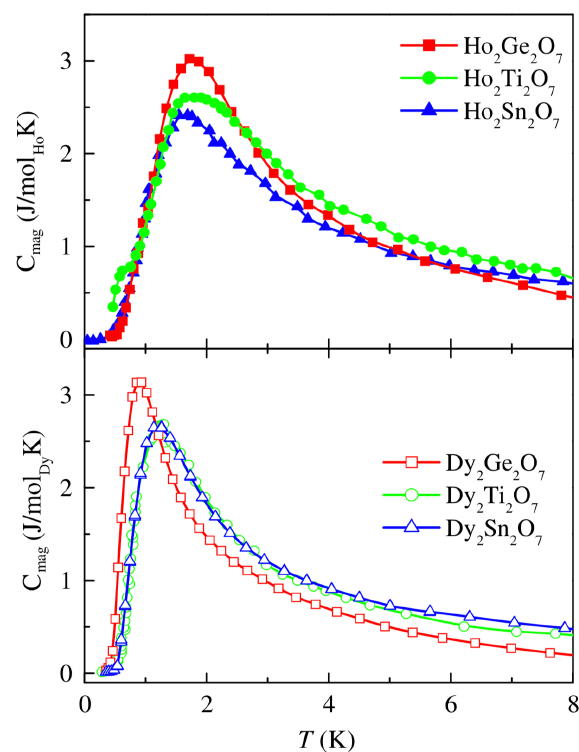
Figure 7. (color online) Magnetic specific heat for all six pyrochlore spin ices. The data for Ho 2 Sn 2 O 7 are from [30], Ho 2 Ti 2 O 7 from [31], and Dy 2 Ti 2 O 7 from [32]. From Ref. [25].